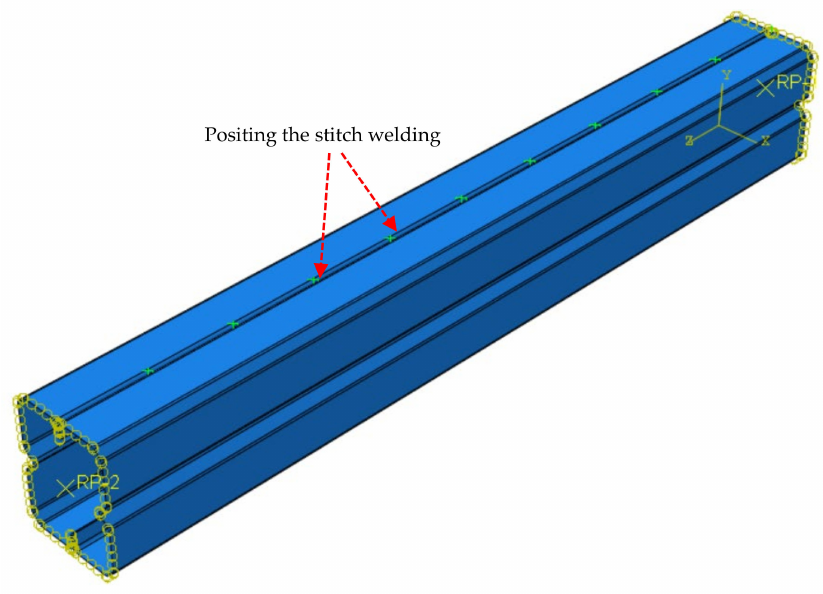
Figure 13. Arrangement of welds and boundary condition applied in the FE model of